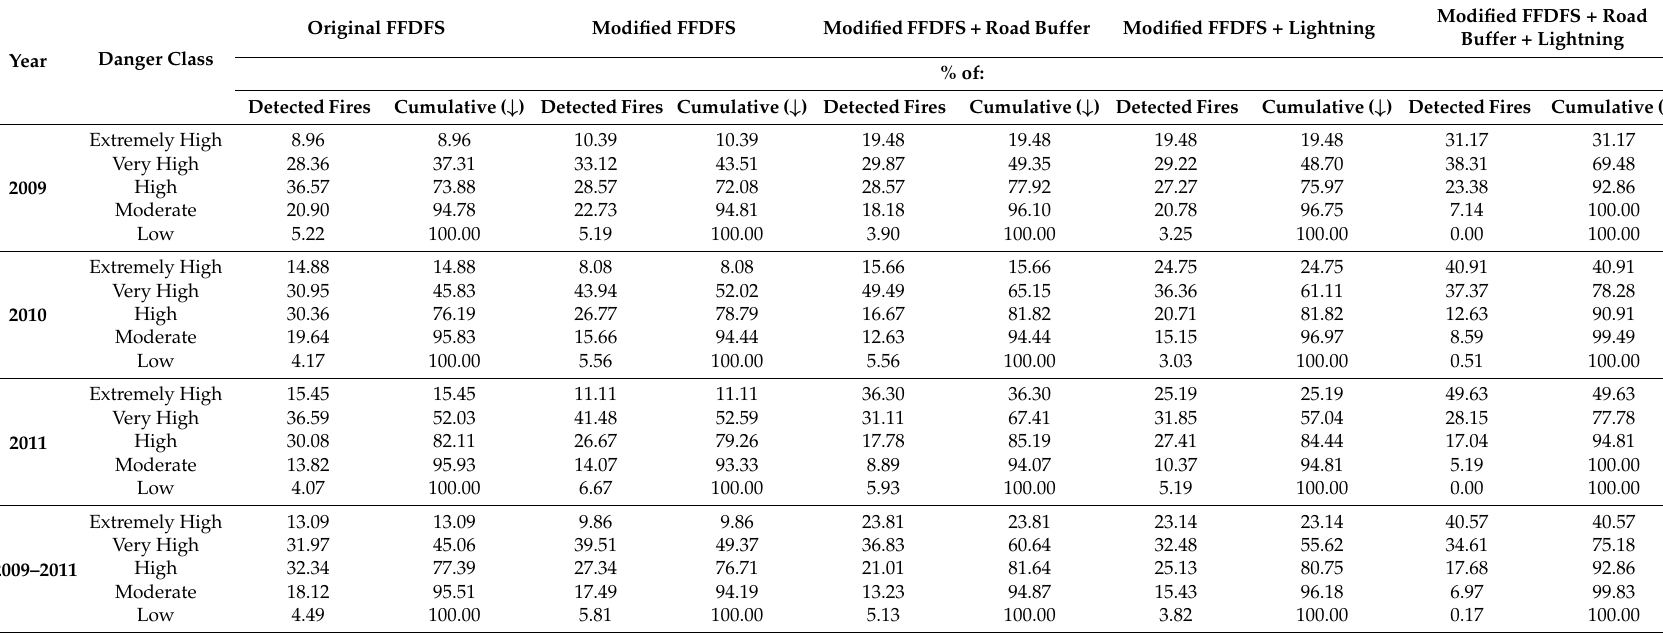
Table 2. Comparison of the modified FFDFS and its integration with road buffers and lightning-caused SFD maps against the ground-based forest fire spots in terms of fire detection